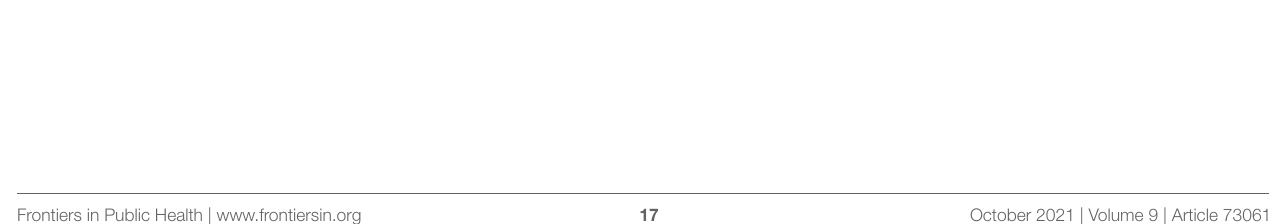
Frontiers in Public Health |